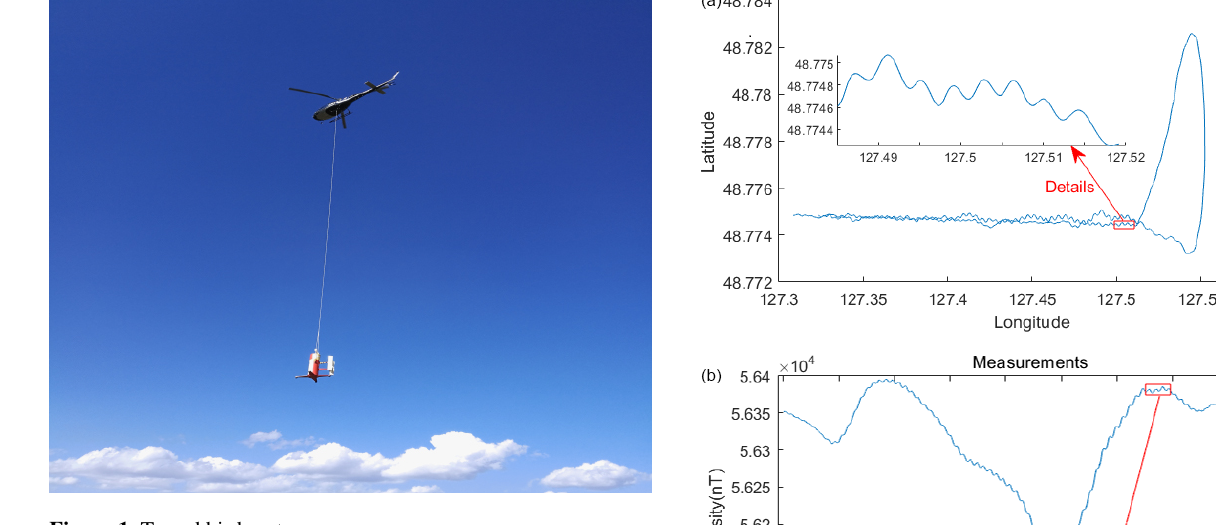
Figure 1. Towed bird system.